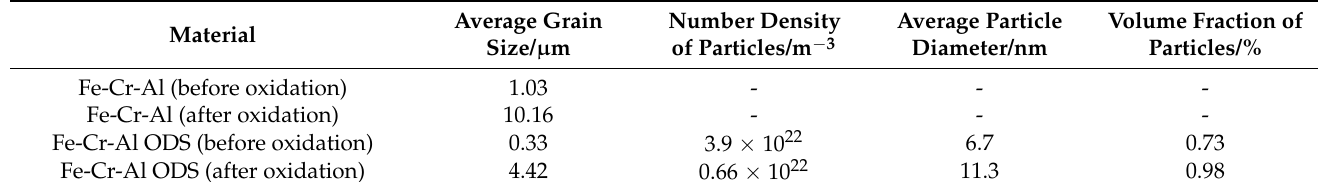
Table 2. Grain size and nano-oxide density, average diameter and volume fraction before and after oxidation of Fe-Cr-Al alloy and Fe-Cr-Al-ODS alloy.